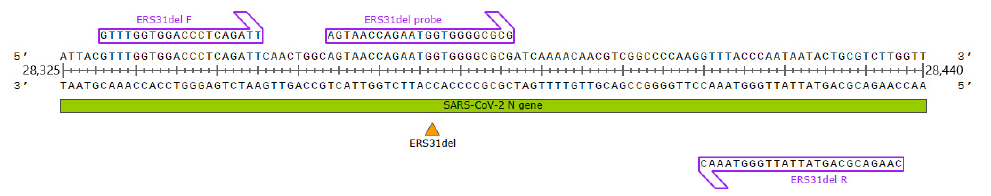
Figure 4. ERS31del oligonucleotides binding scheme.